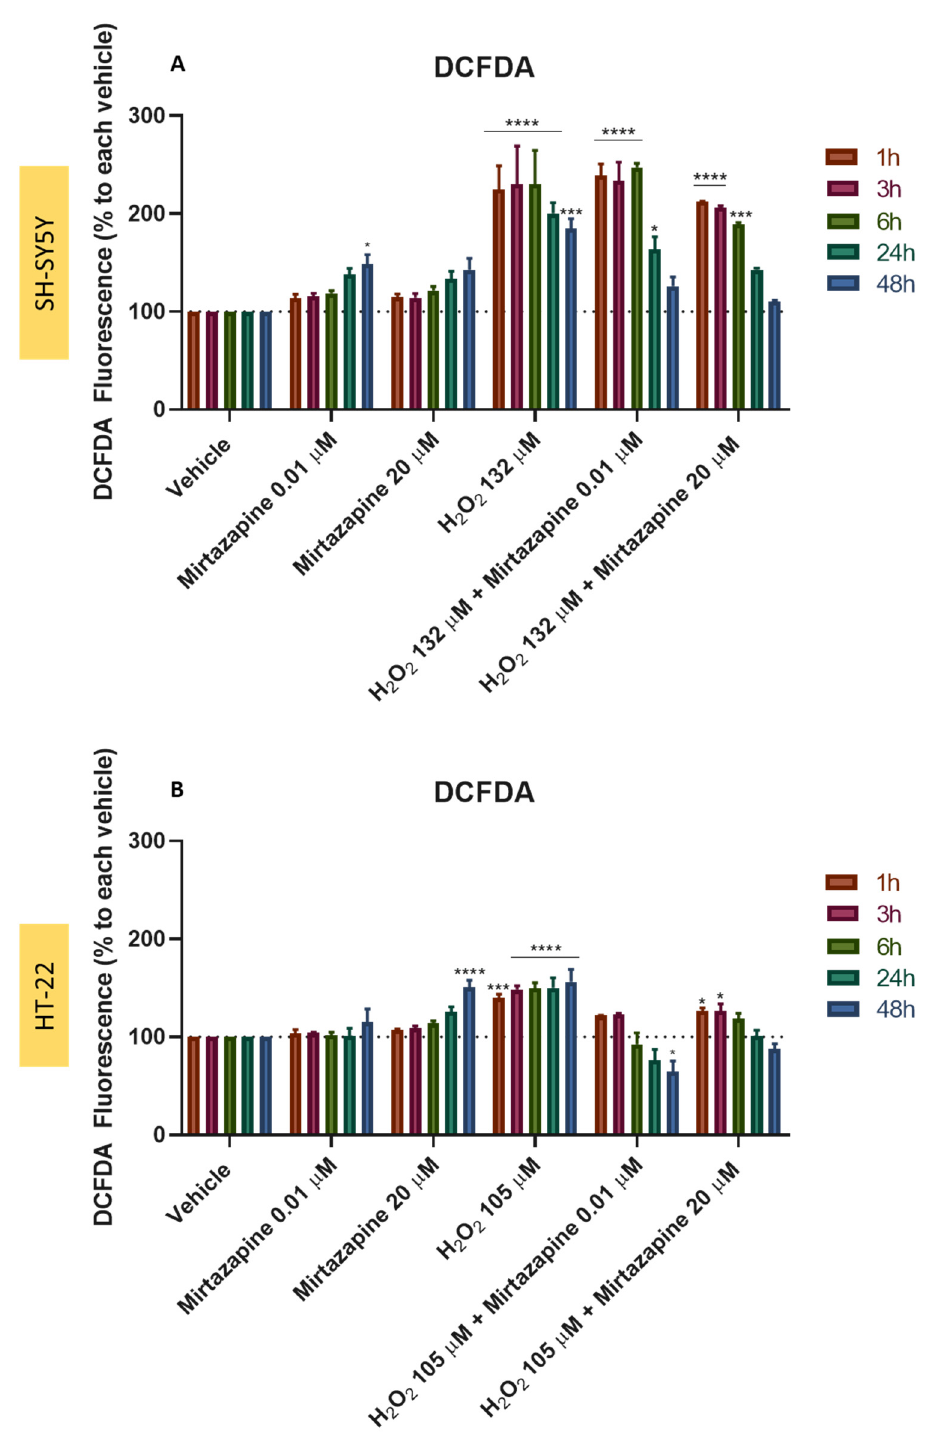
Figure 17. Effect on ROS production of 1 h, 3 h, 6 h, 24 h, and 48 h-incubation of ( A ) 132 µ M of H 2 O 2 , 0.01 µ M/20 µ M of mirtazapine and 132 µ M of H 2 O 2 + 0.01 µ M/20 µ M of mirtazapine (SH-SY5Y cells) and ( B ) 105 µ M of H 2 O 2 , 0.01 µ M/20 µ M of mirtazapine and 105 µ M of H 2 O 2 + 0.01 µ M/20 µ M of mirtazapine (HT-22 cells), determined by DCFDA assay. The results represent the mean ± SEM of 2–6 independent experiments, expressed as the percentage of each vehicle (100%) for each period. Statistically significant * p < 0.05, *** p < 0.001, and **** p < 0.0001 vs. vehicle, for each time.